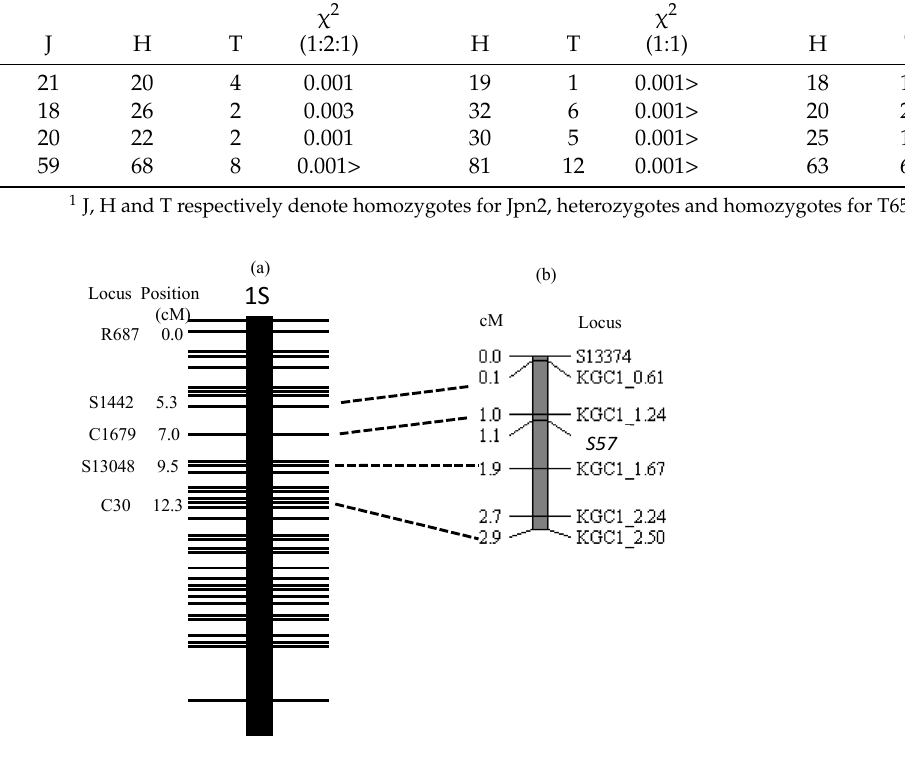
Figure 3. Linkage map showing S57 gene on the short arm of chromosome 1. ( a ) RFLP framework map of the short arm of chromosome 1 modified from Harushima et al. [26]. ( b ) linkage map of S57 gene constructed from the BC 5 F 5 population using Jpn2 as donor parent and T65 as the recurrent parent ( n = 506). DNA markers near each other on Nipponbare pseudomolecules are connected by dotted lines.